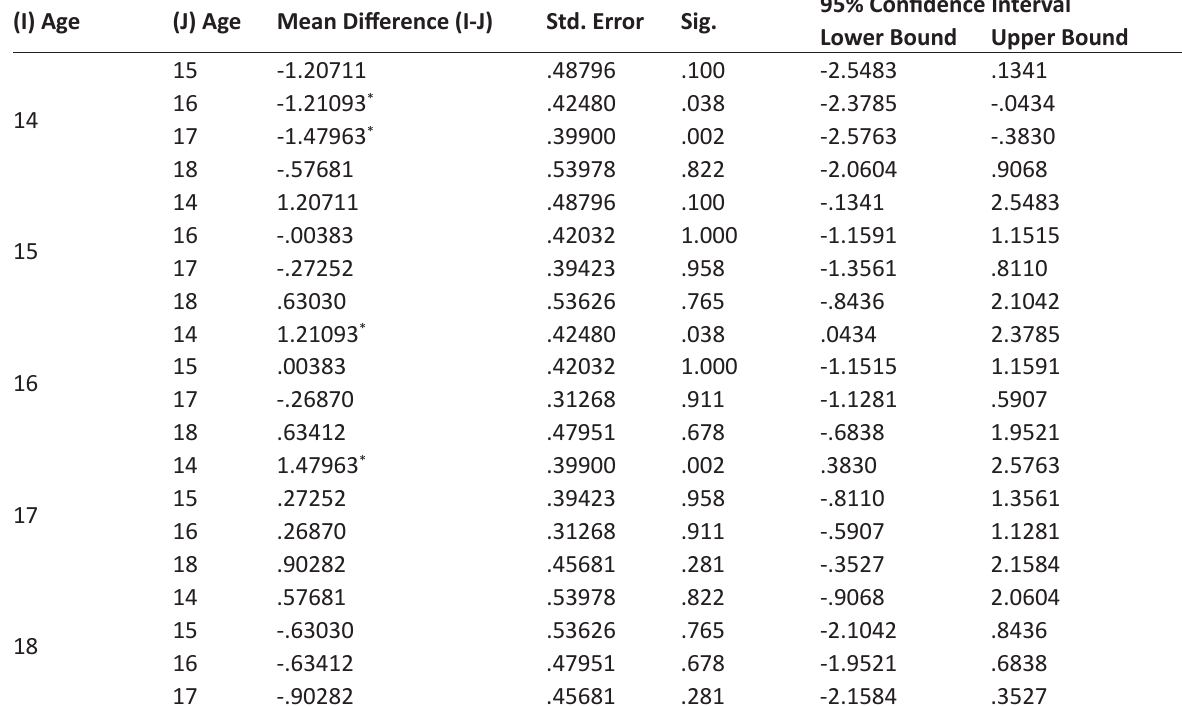
Table 5. Body mass index in female subjects depending on age – multiple comparisons a with Tukey Hsd (I)